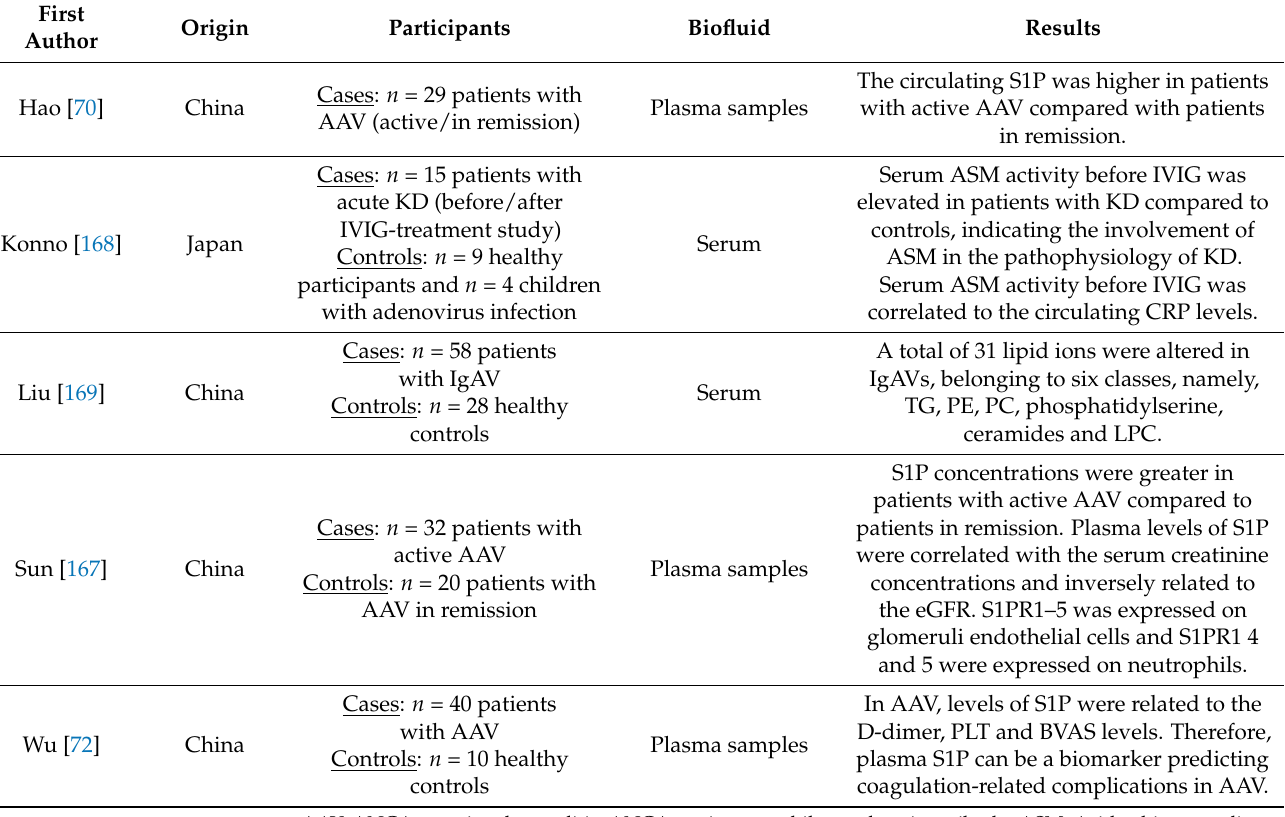
Table 8. Summary of studies assessing ceramide levels in patients with